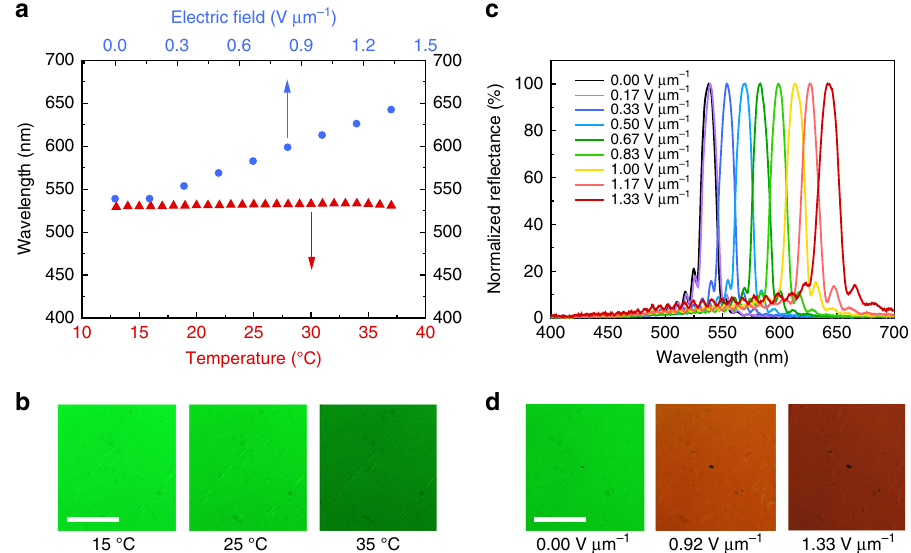
Fig. 6 Temperature-invariant and electrically tunable photonic bandgap of large polymer-stabilized BP monocrystal. a Temperature and electric fi eld dependences of the peak re fl ection wavelength. b Microscope images at different temperatures ( scale bar , 500 μ m). c Re fl ection spectra at different direct current fi eld strengths. d Microscope images at different fi eld strengths ( scale bar , 500 μ